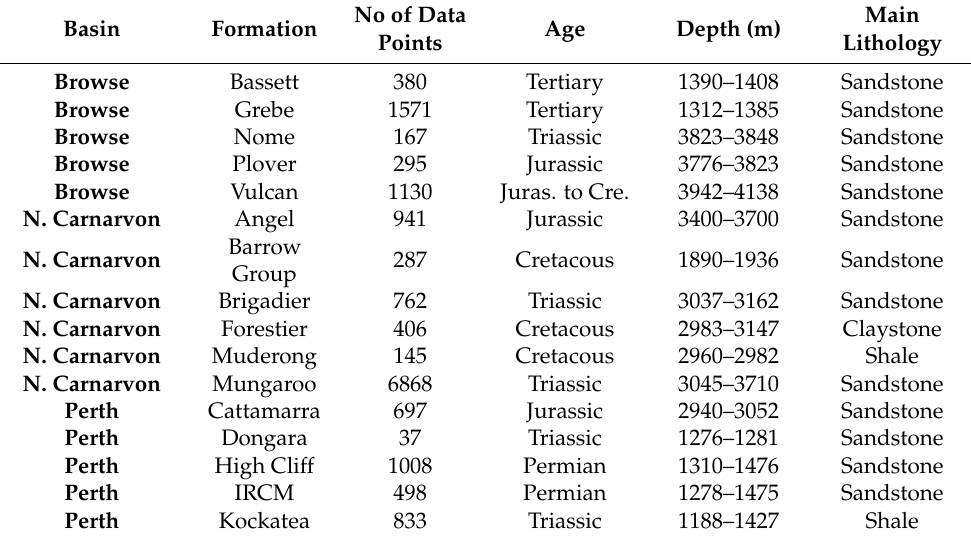
Table 1. The list of the basins, number of data points for each formation, age, depth interval, and type of lithology used in this